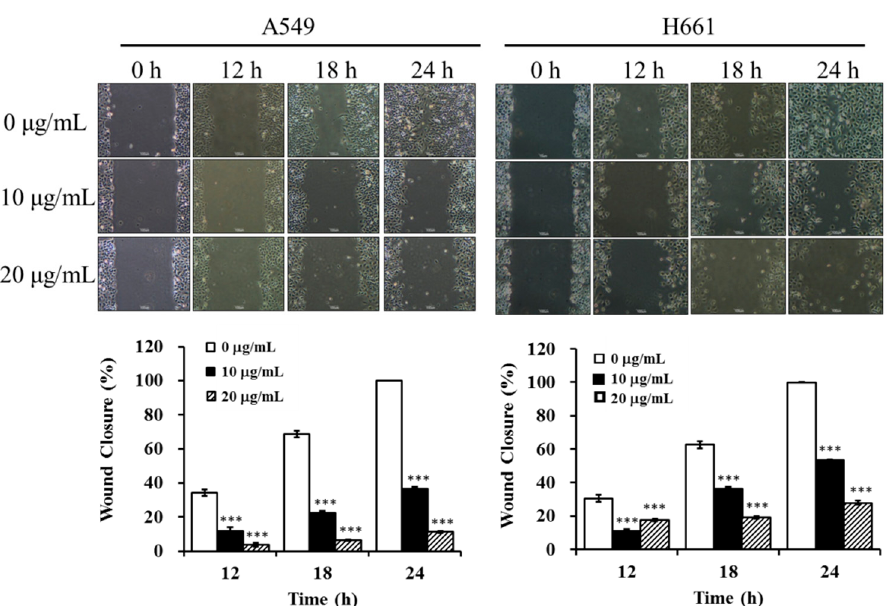
Figure 6. Effect of BSE on A549 and H661 cell migration by wound healing assay. A549 and H661 were seeded into culture dishes and grown to 90% confluence in 6 cm dishes. The cells were scratched with a sterile tip, BSE (0, 10 and 20 μ g/mL) were added and the wounded area were photographed at 0, 12, 18 and 24 h. The inhibitory effect on cell migration is expressed as the level of wound closure. A significant difference from the vehicle was indicated as *** p < 0.001 (Student’s t -test).